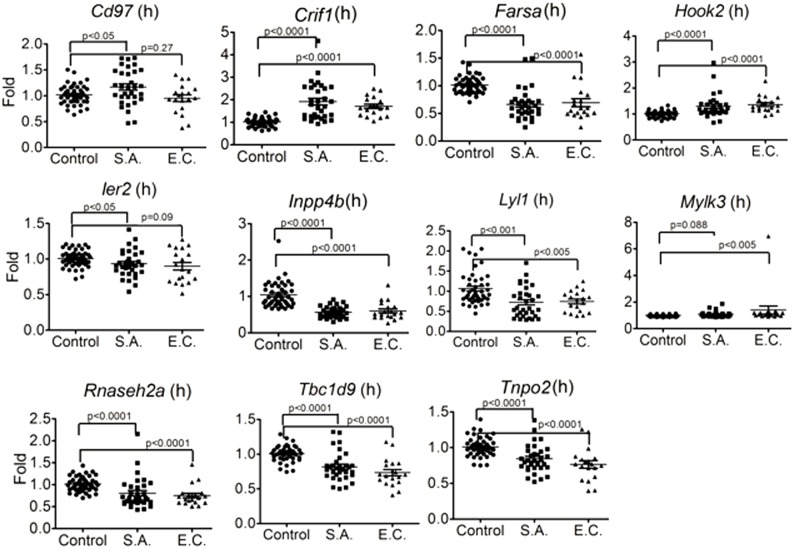
Human orthologues of 11 candidate genes were significantly differentially expressed between patients with blood stream infection (BSI) due to S. aureus (S. A.), E. coli (E.C.) and healthy subjects (Control).Human orthologues of 11 candidate genes (Crif1, Farsa, Inpp4b, Tnpo2, Cd97, Hook2, Ier2, Lyl1, Mylk3, Rnaseh2a and Tbc1d9) were significantly differentially expressed between patients with S. aureus BSI and healthy subjects by microarray. Human blood RNA from patients with S. aureus BSI (n = 32) and healthy subjects with no infection (n = 44) were extracted and analyzed and applied to microarray. The expression of Cd97 (1.17 fold; p<0.05), Crif1 (1.87 fold; p<0.0001), Hook2 (1.30 fold; p = 0.0001) were significantly higher in S. aureus BSI patients as compared with healthy controls. By contrast, the expression of Farsa (0.66fold; p<0.0001), Ier2 (0.93 fold; p<0.05), Inpp4b (0.54fold; p<0.0001), Lyl1 (0.72 fold; p<0.001), Rnaseh2a (0.81 fold; p = 0.001), Tbc1d9 (0.51 fold; p<0.0001) and Tnpo2 (0.84fold; p<0.0001), were significantly lower in S. aureus BSI patients. All of the 11 genes except Cd97 showed similar expression changes in Escherichia coli BSI (n = 19) patients.